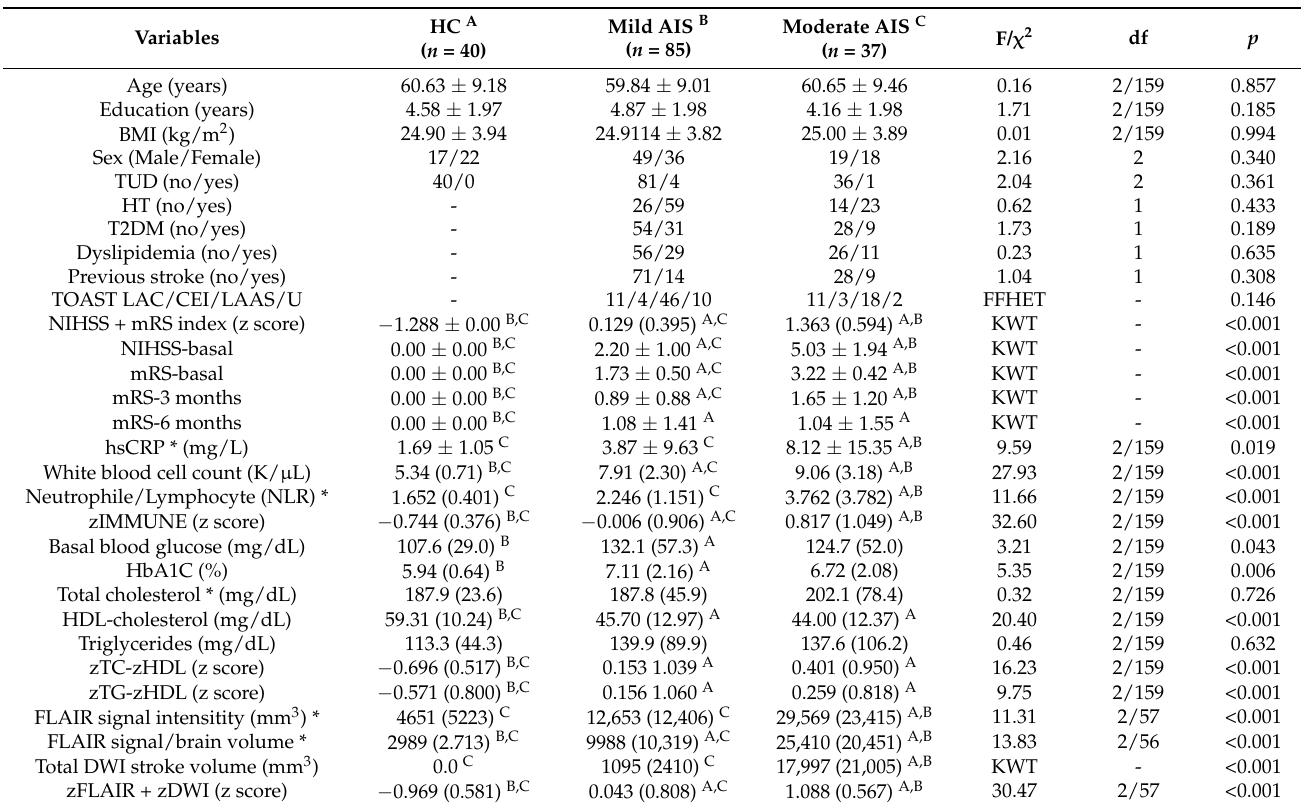
Table 1. Clinical and biochemical data of healthy controls (HC) and patients with acute ischemic stroke (AIS) divided into those with mild (Mild AIS) and moderate (Moderate AIS) severity and healthy controls